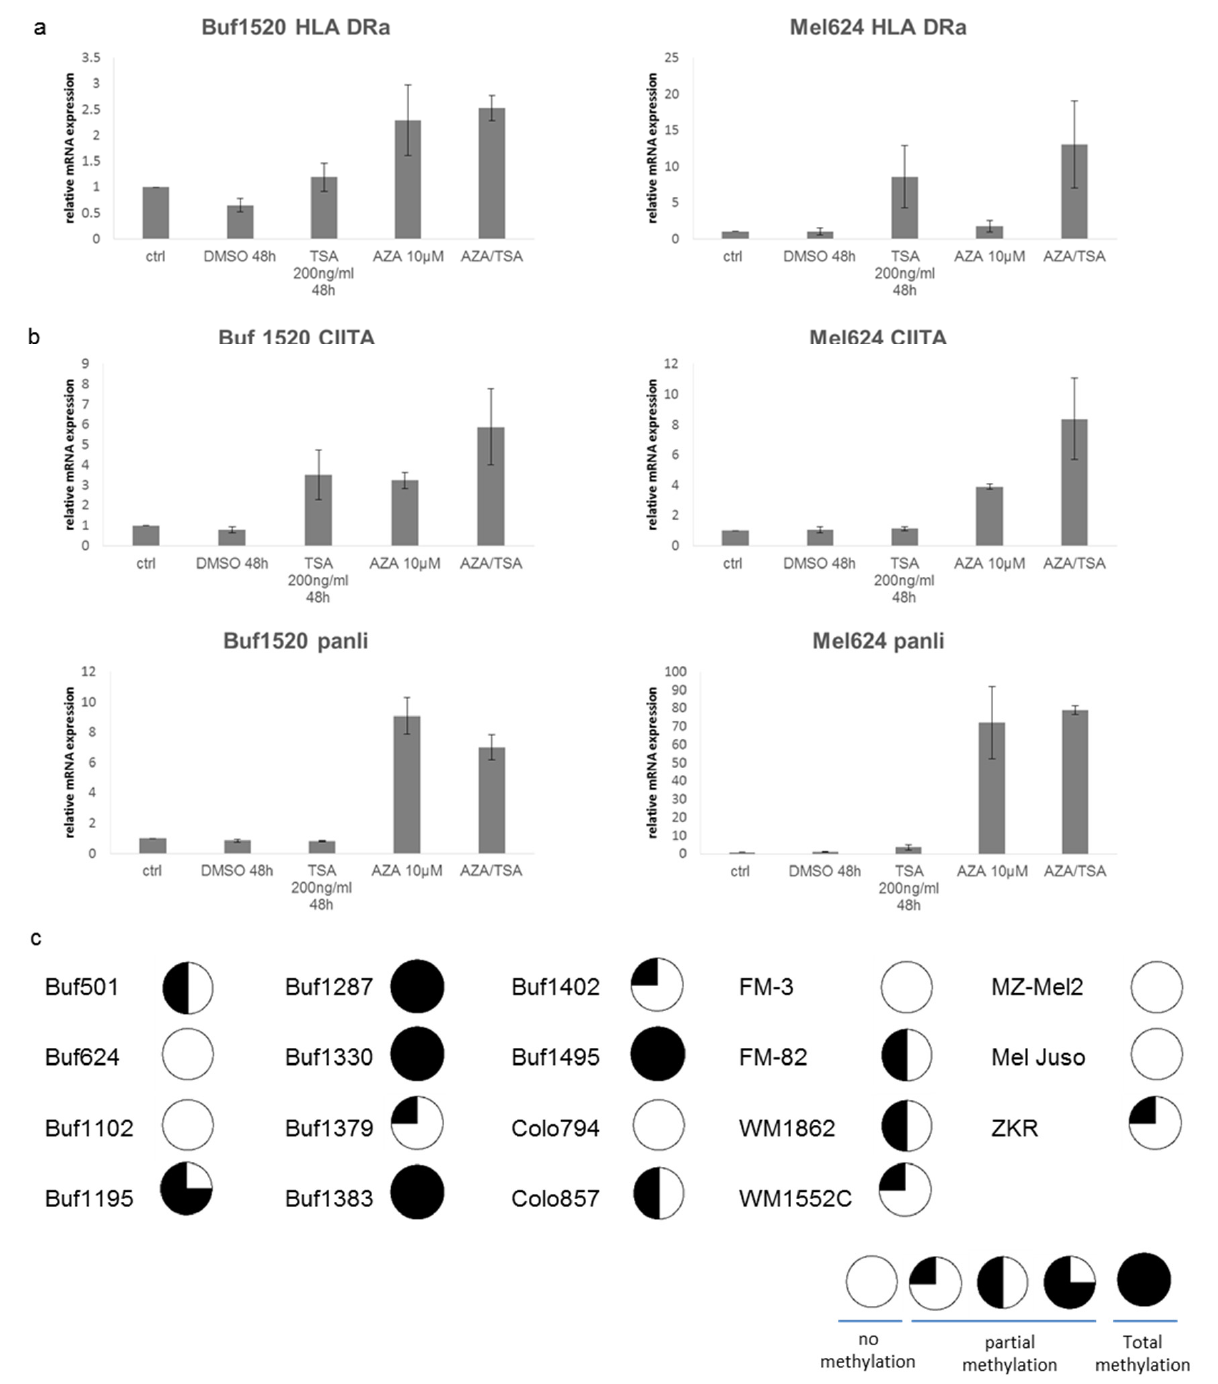
Figure 4. Epigenetic control of HLA class II APM components. Melanoma cells were left untreated or treated for 48 h with AZA (10 µM), TSA (200 ng/mL) and/or a combination of both, before mRNA expression of HLA-DR I ( a ) and HLA class II APM components ( b ) was determined by qPCR. The data are expressed as relative mRNA levels by setting untreated cells as 1. The data are shown as mean ± SE from two different experiments. ( c ) The methylation status of CIITA was analyzed in HLA class II negative melanoma cell lines, as described in Materials and Methods. The results are presented as total, partial (25–75%) and no